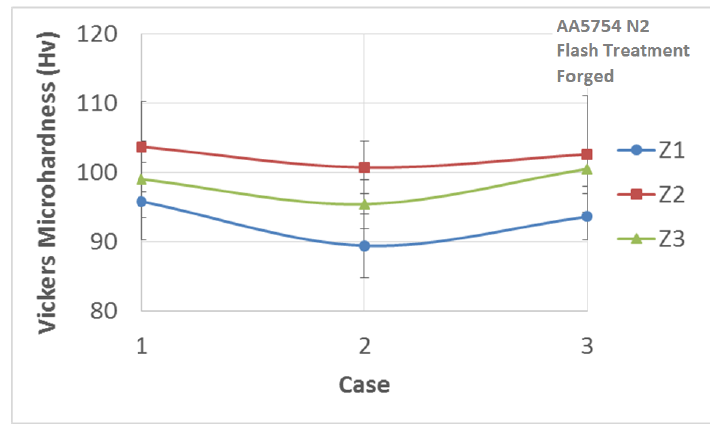
Figure 6. Microhardness values for the connecting rods forged after the three flash treatments selected.